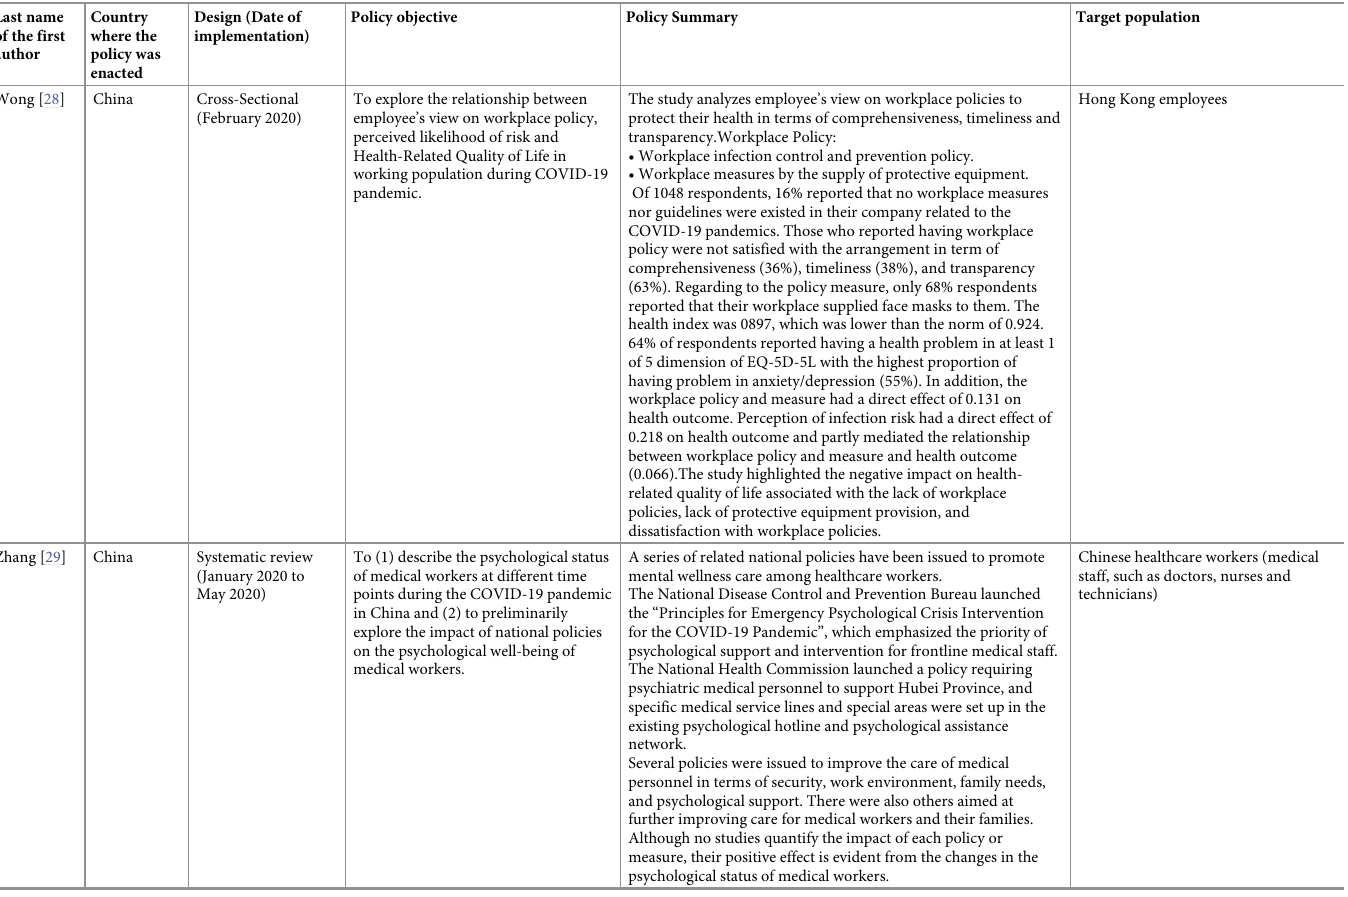
Table 1. Studies included in the scoping review (n =